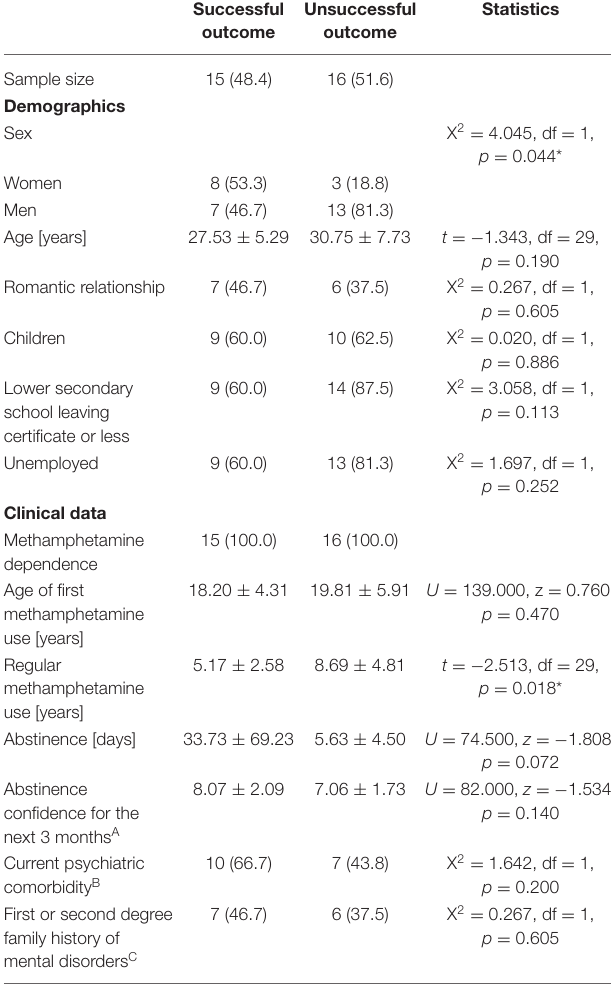
TABLE 1 | Participant characteristics at